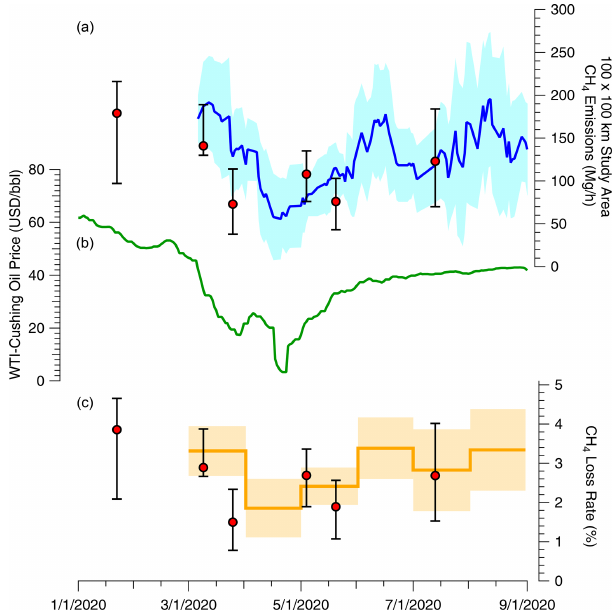
Figure 6. Temporal variation in methane emissions and crude oil price. (a) Aerial (red circles with 95% CI error range) and tower- based 7-point moving average and 95% CI (blue line and shad- ing) atmospheric estimates of 100km × 100km study area CH 4 emissions. (b) 7d moving average of WTI-Cushing daily oil price. (c) Orange line and shading presents resulting CH 4 loss rate com- bined aerial and tower-based measurements utilizing published monthly gas production within the study area (Enverus, 2021). Red points present the loss rate utilizing only the aircraft-based emission estimates and the monthly gas production during the month of the flight.